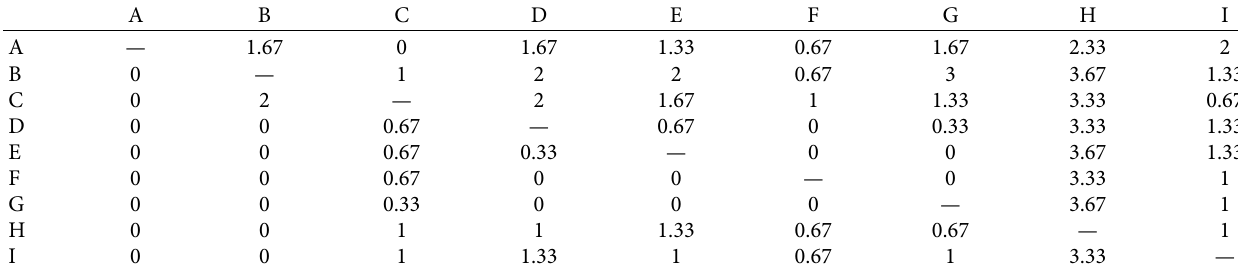
Table 15: The initial direct relation matrix for economic aspects.